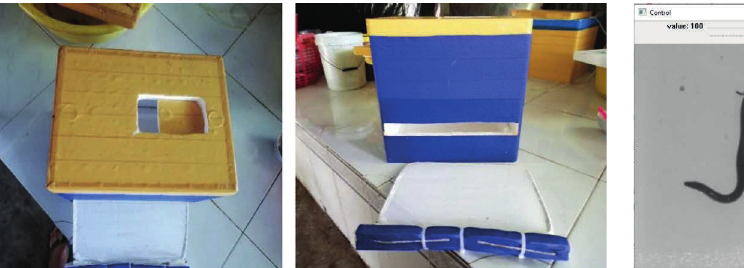
Fig. 3. A simple photo box to capture images of eels.